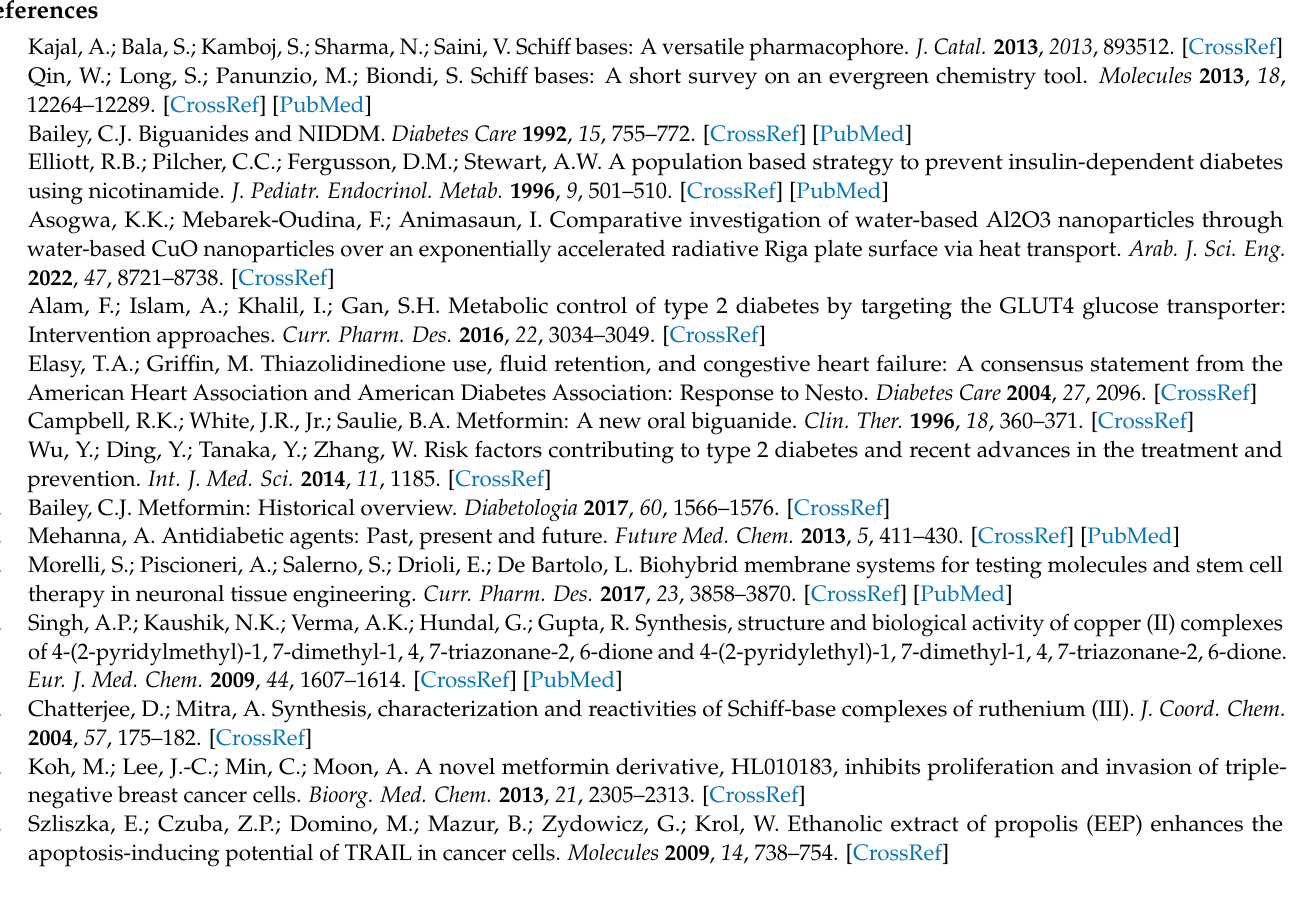
Figure S5: Graphical representation of α -amylase activity of MCu1–MCu9; Figure S6: Graphical representation of α -amylase activity of MZn1-MZn9; Figures S7–S31: IR and NMR spectras of all the metformin metabolites and metal